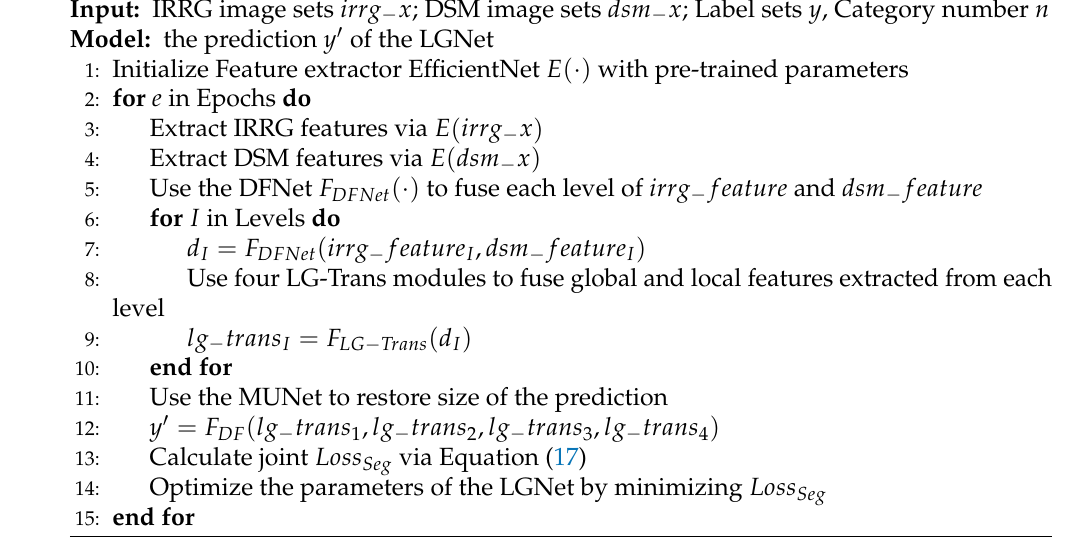
Algorithm 1 Optimization of the LGNet.